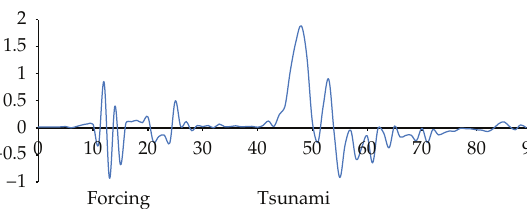
Figure 3: DART 21418: Data showing earthquake (cid:2) forcing , on the left (cid:3) and resulting tsunami (cid:2) on the right (cid:3) observed on March 11, 2011, from 5:43 am to 6:51 am (cid:2) horizontal axis is time in minutes, vertical axis is in meters (cid:3)